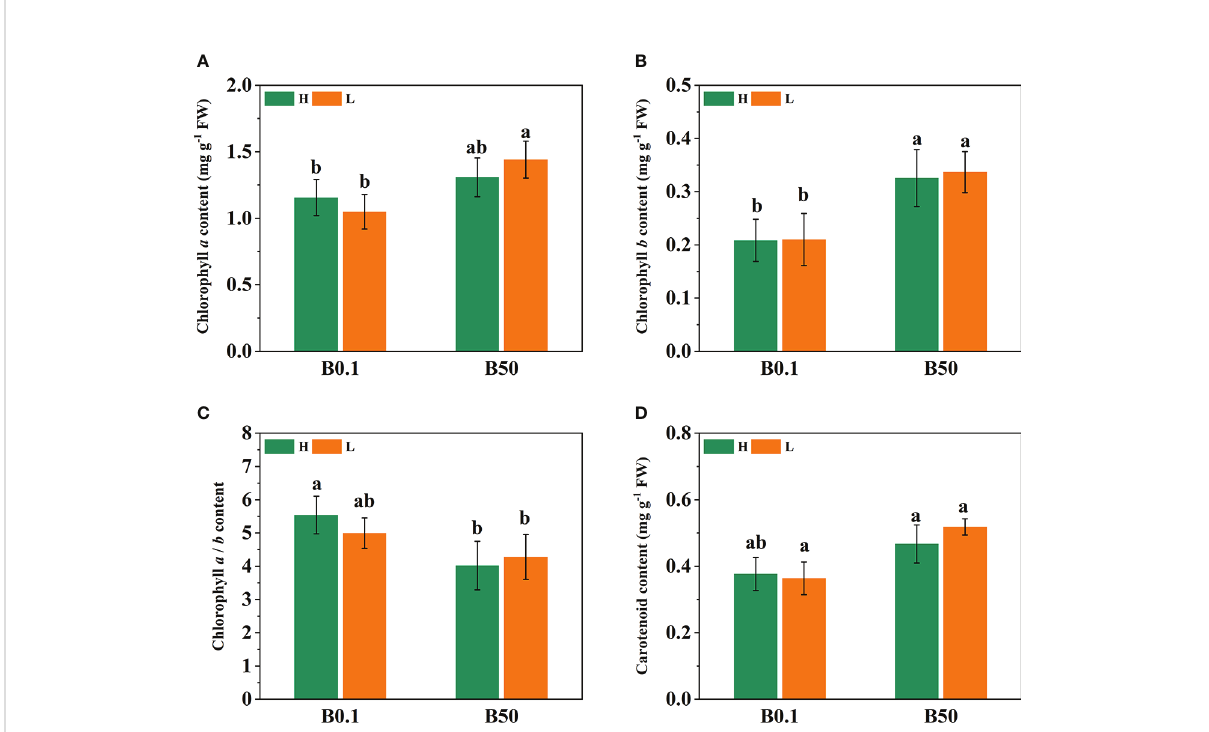
FIGURE 3 Effect of chlorophyll pigments in KWS1197 and KWS0143 cultivars. The seedlings were treated with B de fi cient (0.1 m M H 3 BO 3 , B0.1) and B suf fi cient (50 m M H 3 BO 3 , B50) treatments. The chlorophyll pigments include the content of chlorophyll a (A) , chlorophyll b (B) carotenoid (D) and the ratio of chlorophyll a to chlorophyll b (C) . Different lowercase letters (a, b, c) indicated signi fi cant differences between different treatments. Bars denote the mean (n=3) and standard error